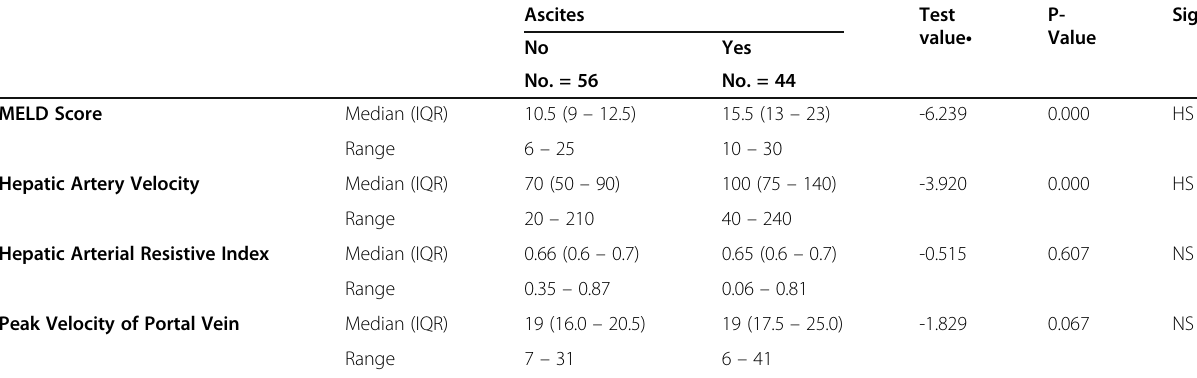
Table 4 The presence of ascites and correlation with MELD and other Hepatic Doppler parameters